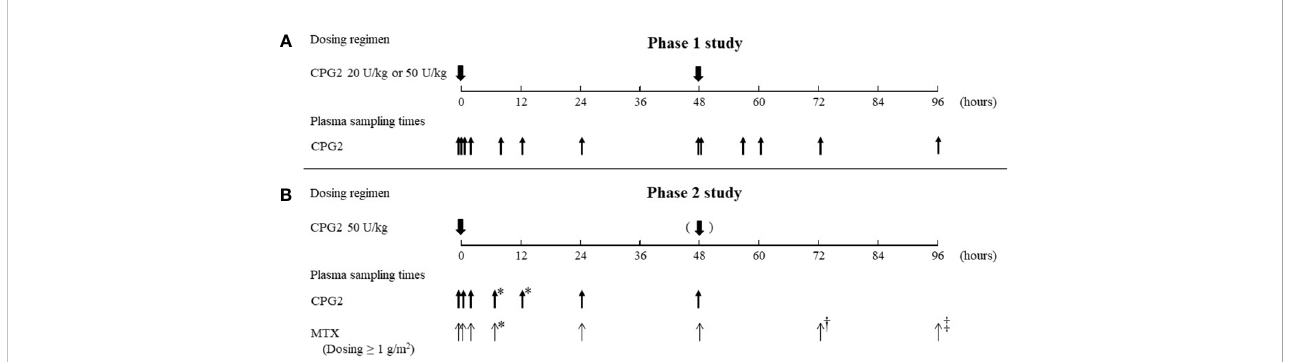
FIGURE 1 Summary of the dosing regimen of CPG2 and blood sampling of CPG2 and MTX. CPG2, glucarpidase; MTX, methotrexate. (A) Blood sampling of CPG2 in the phase 1 study. First dosing of CPG2: before dosing, at 5 and 15 min, and 2, 8, 12, 24, and 48 h (before second dosing of CPG2) after dosing. Second dosing of CPG2: 5 min and 8, 12, 24, and 48 h after dosing. (B) Blood sampling of CPG2 in the phase 2 study. First dosing of CPG2: before dosing, at 20 min, and 2, 5 – 8*, 12 – 20*, 24, and 48 h after dosing. Blood sampling of MTX. First dosing of CPG2: before dosing, at 20 min, and 2, 5 – 8*, 24, 48, 72 † , and 96 ‡ h after dosing. *Before leucovorin dosing; † 24 h after and dosing of CPG2; ‡ 48 h after second dosing of CPG2.